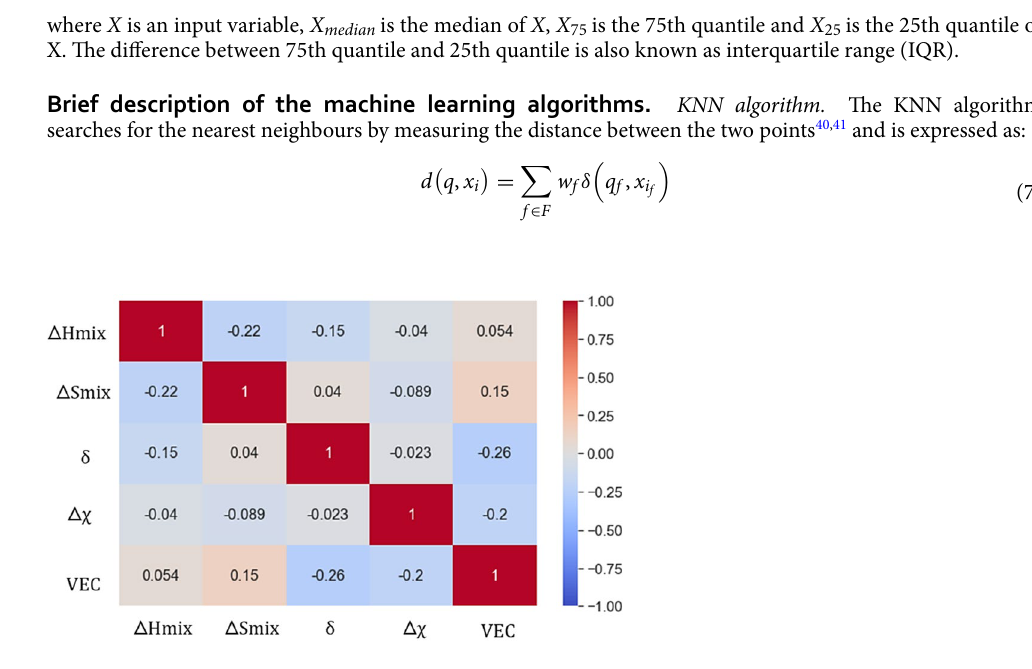
Figure 3. Heatmap showing the Pearson correlation coefficient among five HEA